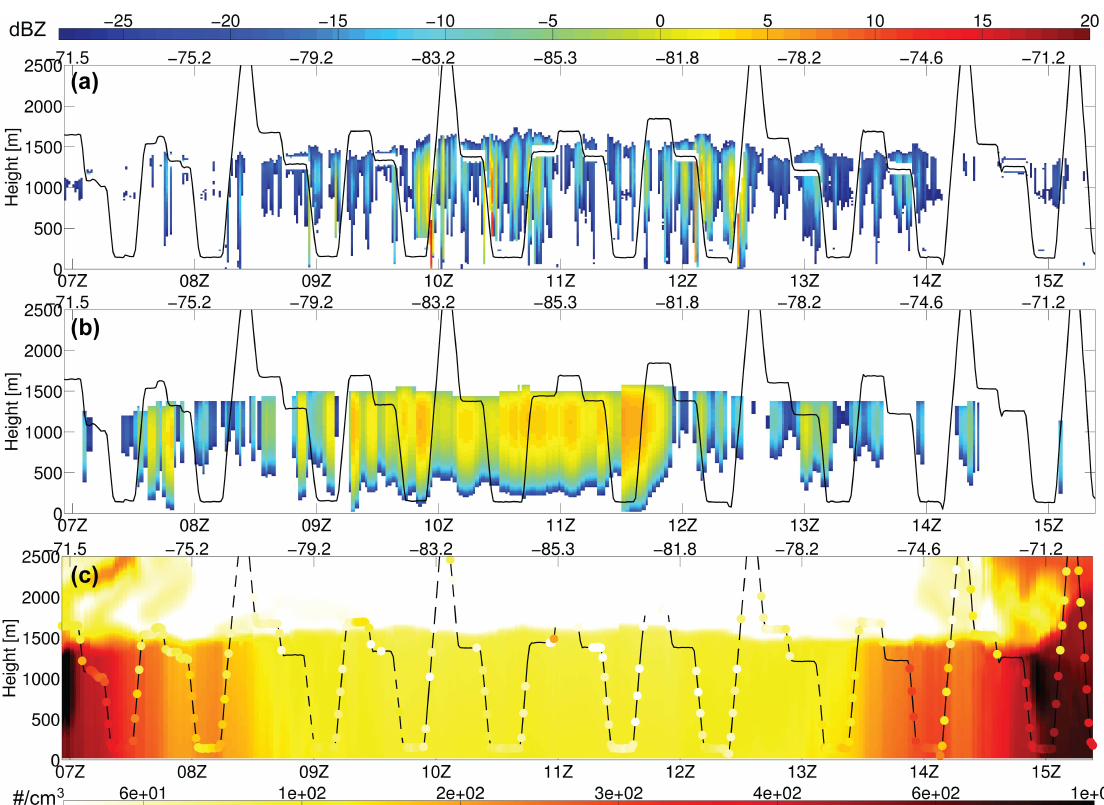
Fig. 9. Curtain plots for radar reflectivity (Z, in dBZ) and accumulation mode aerosol number concentration (#cm − 3 ) for C-130 flight RF05 on 25 October. (a) and (b) shows radar observed and NW model Z while (c) shows NW model as the curtain and one minute average PCASP observations as colored circles. Observed Z and PCASP aerosol are 1min averages. Model Z is computed according to Appendix A. Solid lines represent flight track with the line becoming segmented on (c) every time there is a PCASP observation. For all panels, bottom scale is time in hours and top scale is longitude in degrees.